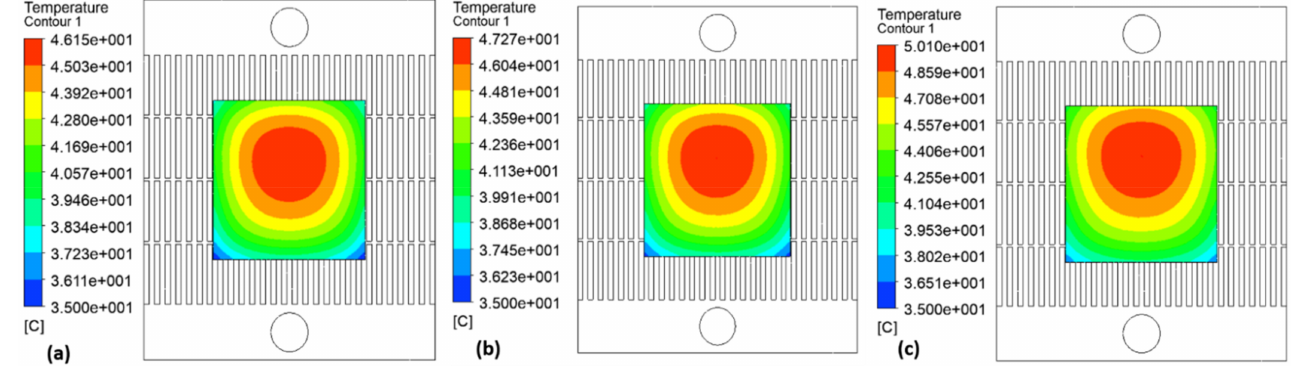
Figure 8. Base temperature distribution of three SPFMCHSs with 1 mm fin spacing: ( a ) 0.5 LPM, ( b ) 0.75 LPM, and ( c ) 1 LPM.